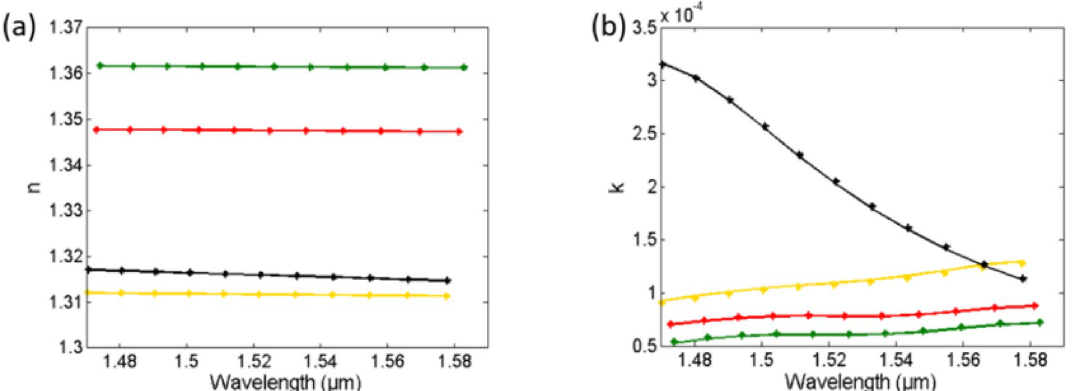
Figure 6. Actual "solid" (from data in 30,31 ) and detected "asterisk" (from our method) medium refractive index versus wavelength for different sensing media ( a ) Real part n and ( b ) Imaginary part k.